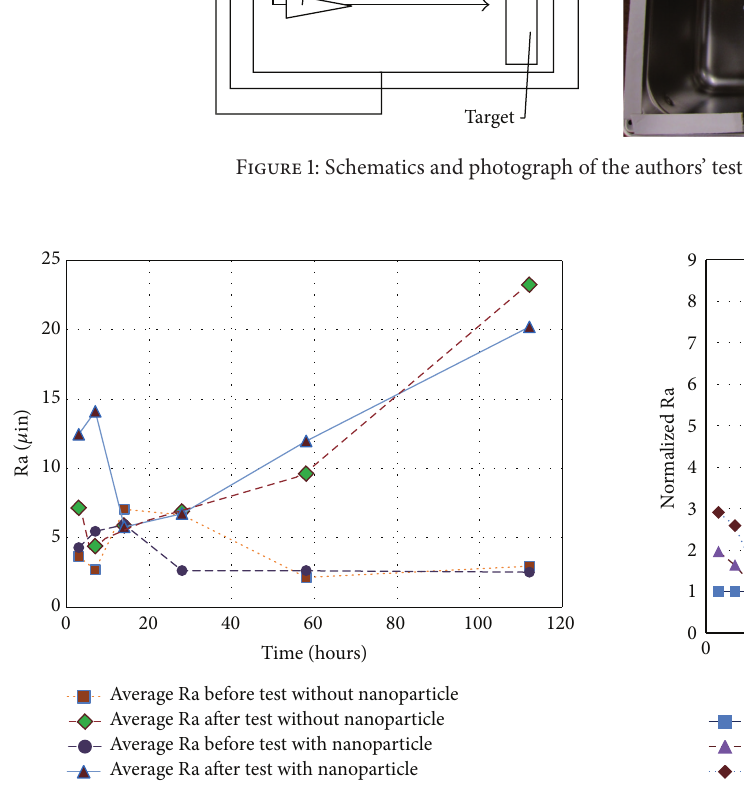
Figure 2: Average Ra roughness for 3003-T3 aluminum before and after 3-, 7-, 14-, 28-, 56-, and 112-hour treatments with the reference fluid of 50/50% ethylene glycol in water and with nanofluid of 2% nanoalumina in reference fluid.